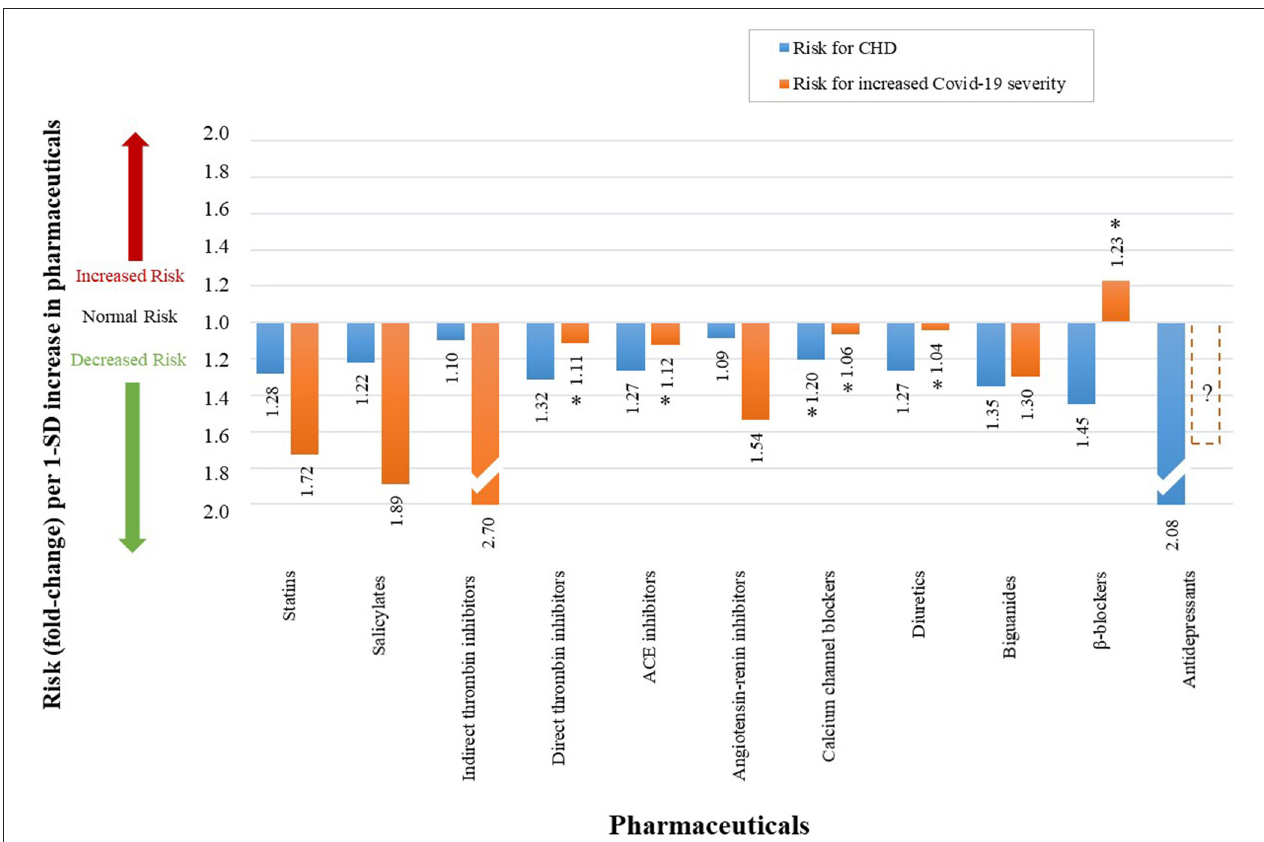
FIGURE 12 | The qualitative effect that different pharmaceuticals have on CHD risk and Covid-19 severity. (An accurate quantitative comparison is not possible, mostly due to differences in study design and